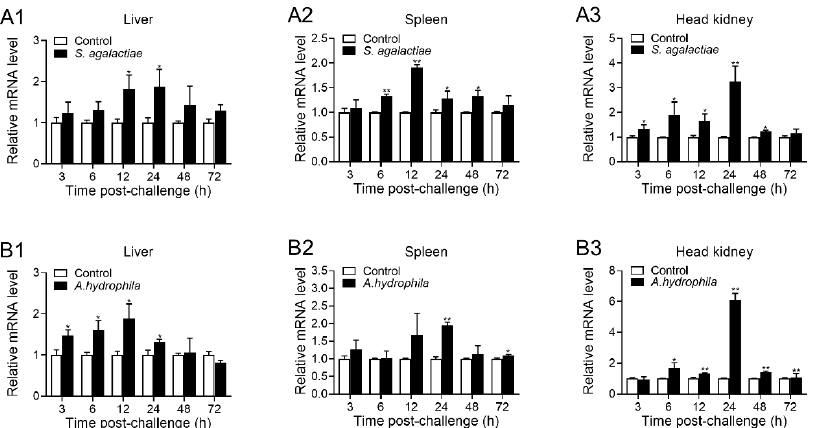
Figure 3. Expression pattern of OnTRAP5b in vivo. The mRNA expression of OnTRAP5b after injection with S. agalactiae ( A1 – A3 ) and A. hydrophila ( B1 – B3 ) in the liver, spleen, and head kidney at various time points. Expression values are normalized against β -actin, and the folding unit was calculated, deciding the values of the vaccinated tissues by PBS. The values are shown as means ± SD ( n = 3), n , the number of times the experiments were performed. ** p < 0.01, * p < 0.05.